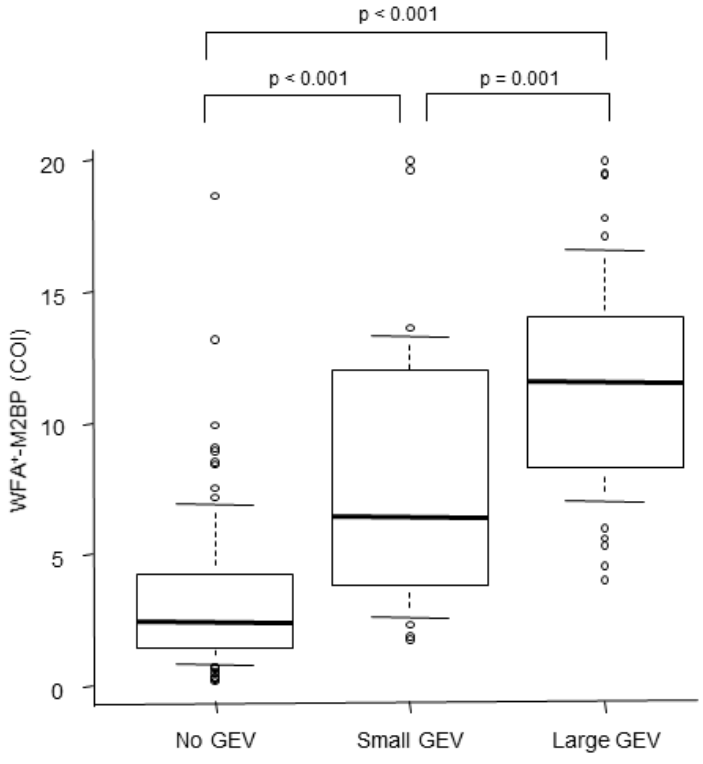
Figure 1. Correlation between the WFA + –M2BP level and GEV. A boxplot of WFA + –M2BP is shown for each grade of GEV. The boxplot represents the 25th to 75th percentiles and gives the interquartile range. The line through the box indicates the median value, and an error bar indicates the minimum and maximum nonextreme values. Table 2. Diagnostic performance of WFA + –M2BP and other serum markers for detecting